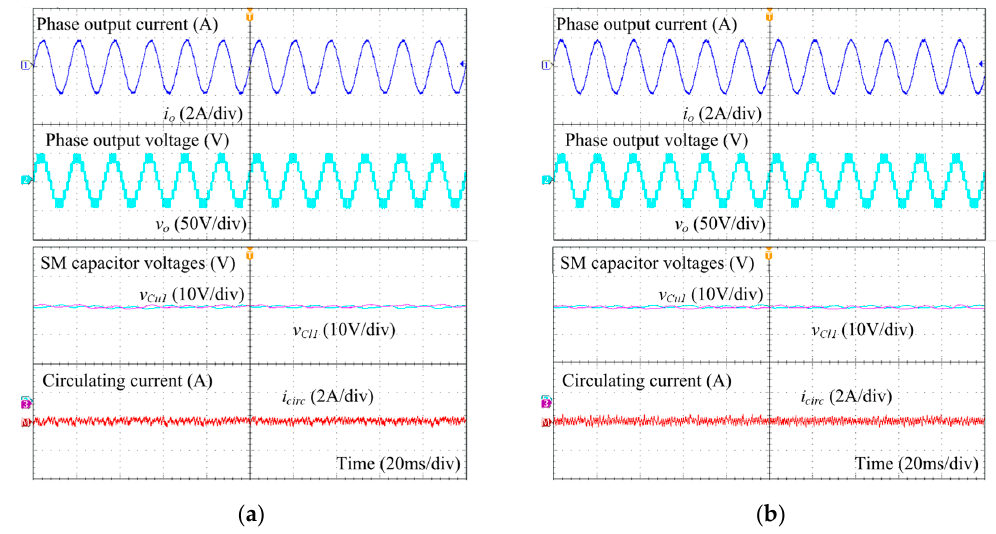
Figure 12. Experimental waveforms of phase output current, phase output voltage, SM capacitor